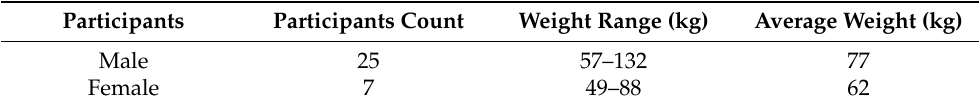
Figure 5. Collection of training data with different sitting positions: ( a ) Forward leaning; ( b ) Backward leaning; ( c ) Right leaning; ( d ) Left leaning. Table 1. Volunteers participated in data set compilation.